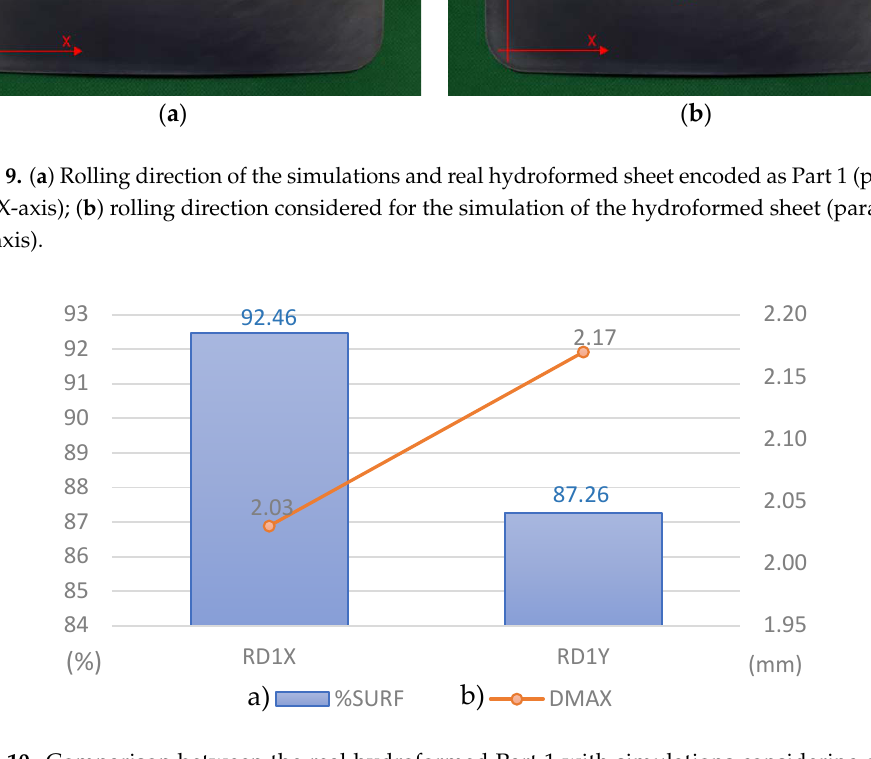
Figure 10. Comparison between the real hydroformed Part 1 with simulations considering rolling direction parallel to X (RD1X) and rolling direction parallel to Y (RD1Y): ( a ) Bar Chart with Surface % with distance between Real and Simulation Parts < 0.5 mm; ( b ) Linear Graph with maximum distance between Real and Simulation Piece.